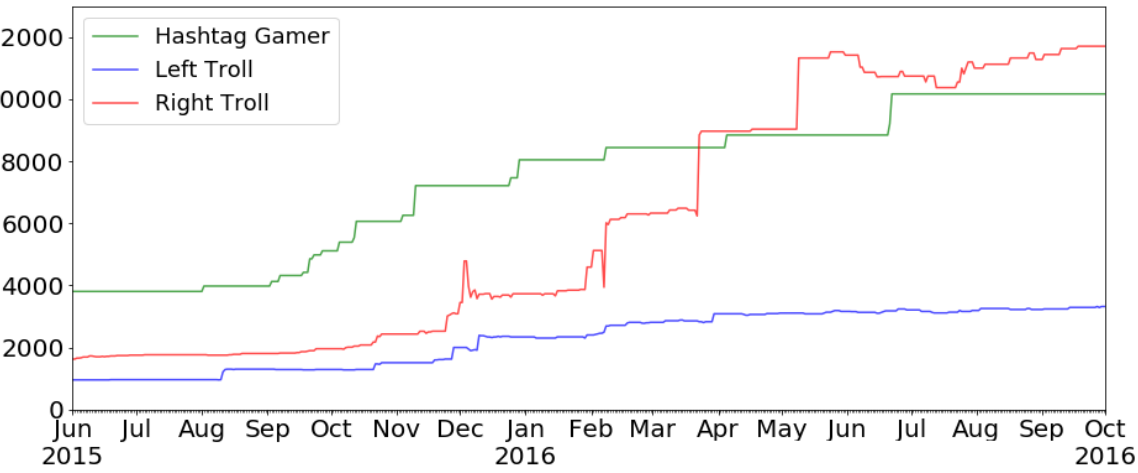
Appendix Figure 3. Approximate Mean Follower Counts for Accounts Where No Projection Exceeds 60